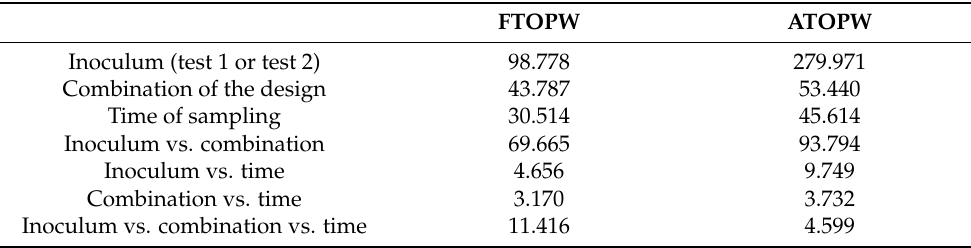
Table 2. Standardized effects of MANOVA. ATOPW, aged table olive processing water; FTOPW, fresh table olive processing